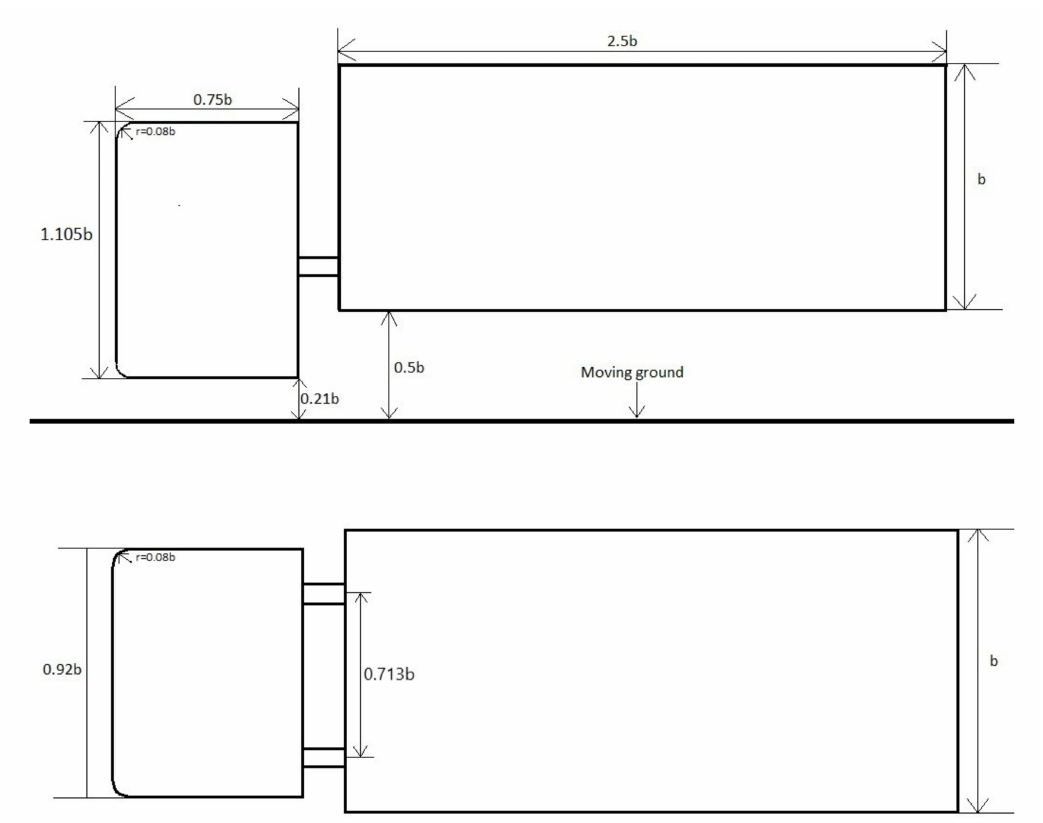
Figure 2. Schematics of the tractor–trailer truck model.